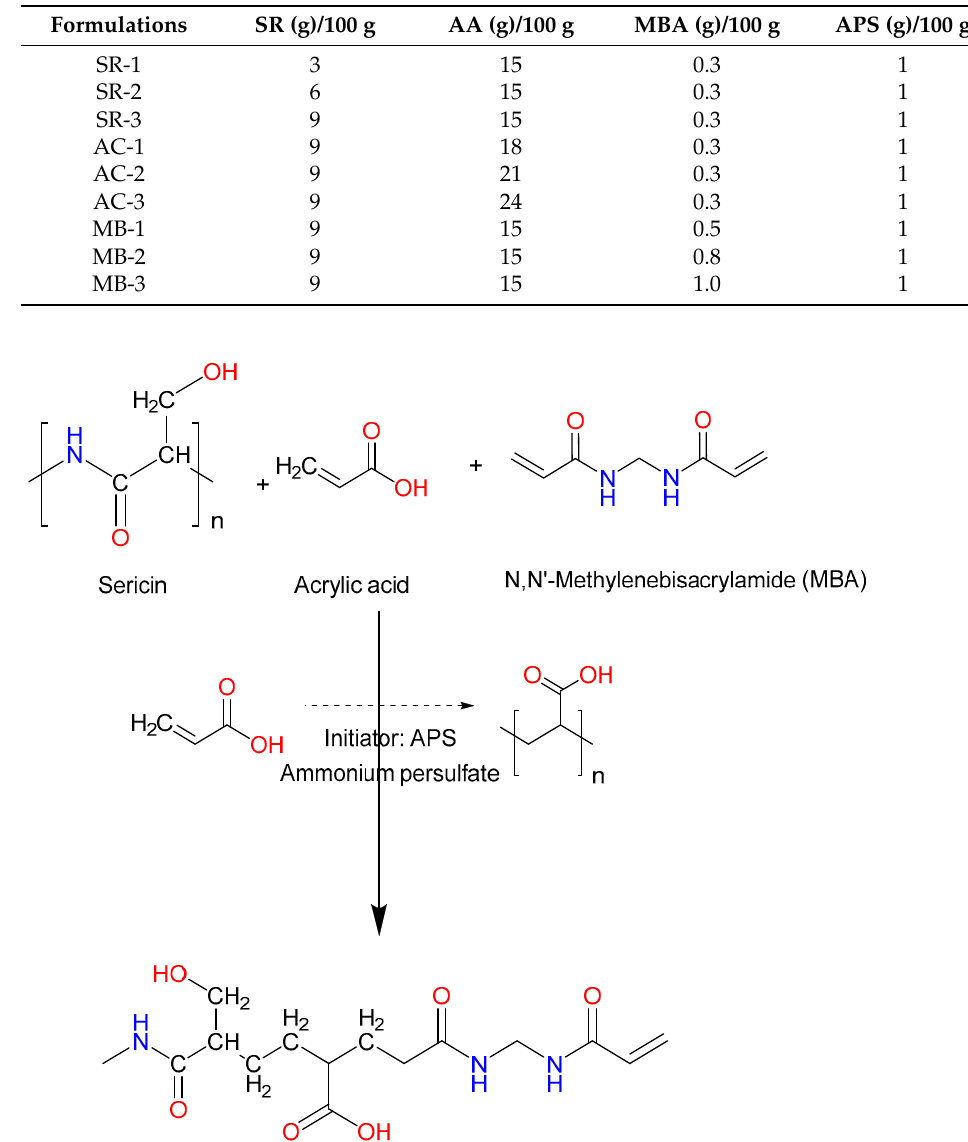
Figure 12. Diagrammatic illustration of ammonium persulfate (APS)-initiated graft copolymerization of acrylic acid onto sericin in the presence of MBA and an anticipated structure of the cross-linked network of the